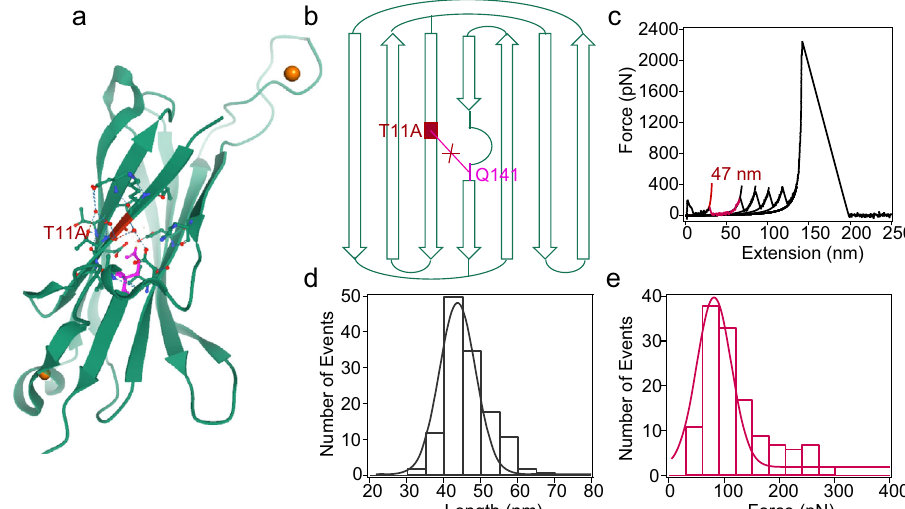
Fig. 2 Mechanical unfolding of the mutated C1 domain without the ester bond. a Thr-11 of C1 was mutated to Ala to eliminate the ester bond to yield the C1 T11A mutant. b Topology of C1 T11A . The ester bond cannot form in the mutant. c Representative single-molecule force – extension curve of stretching Fg β - (GB1) 2 -C1 T11A -(GB1) 2 -cys following the same experimental protocol shown in Fig. 1d. Each peak was fi tted by worm-like chain (WLC) model of polymer elasticity. The peak with a Δ L c of 47 nm corresponds to the unfolding of C1 T11A , the next four peaks correspond to the unfolding of GB1 domains, and the last peak corresponds to the rupture of the Fg β /SdrG complex. d Histogram of contour length increment for C1 unfolding is centered ~47 nm. e Unfolding force histogram of C1 domain at a pulling speed of 1.6 μ m s − 1 measures an average unfolding force of 92 ± 41 pN ( n = 129, total number of C1 unfolding events). Fitting the force distribution with Monte Carlo simulation 65 results in a Δ x u of 0.27 nm and α 0 of 0.35 s − 1 (Supplementary Fig. 8). This experiment was repeated three times independently with similar results. Source data are provided as a Source Data fi